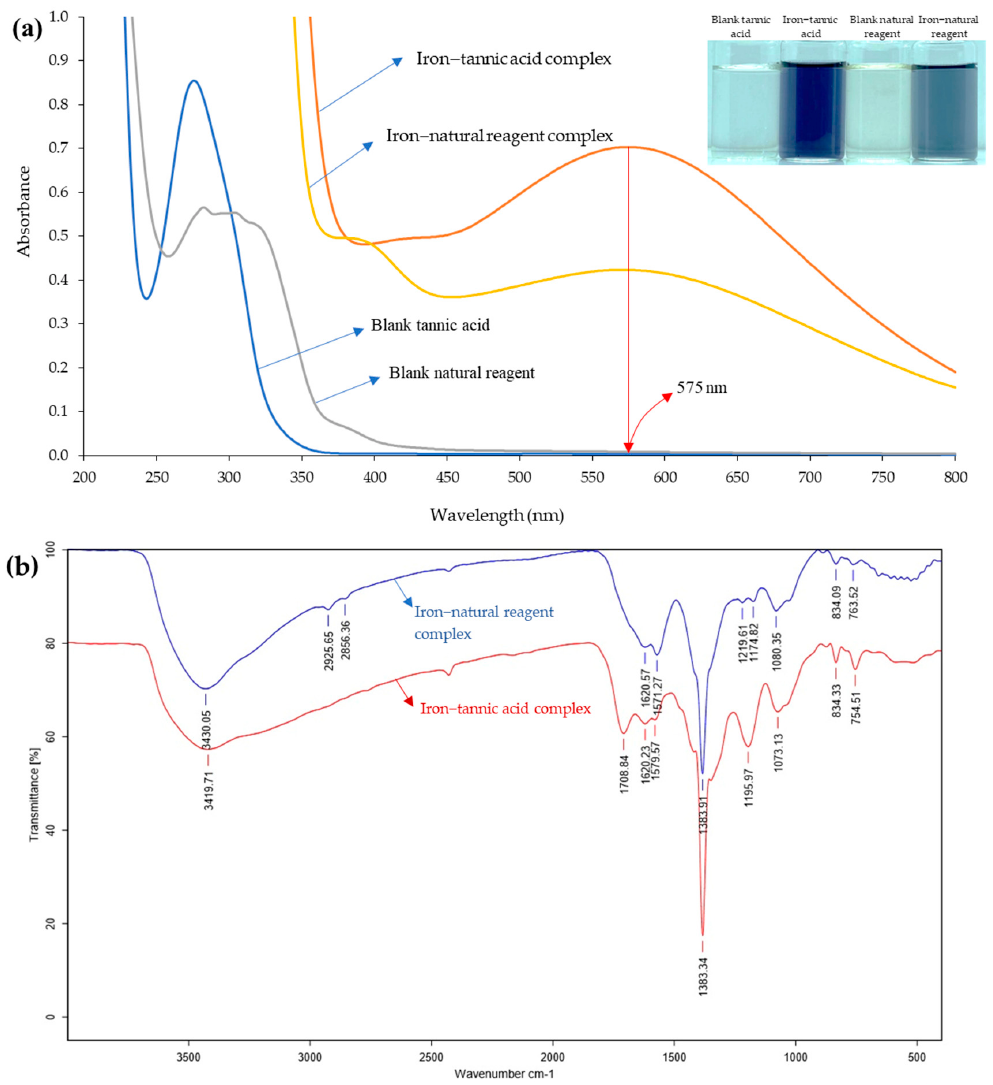
Figure 2. Results of natural reagent − iron complex and tannic − iron complex ( a ) Absorption spectra and digital images of iron associated with natural reagent and tannic acid and ( b ) FT − IR spectra of iron-natural reagent and iron − tannic acid complex.